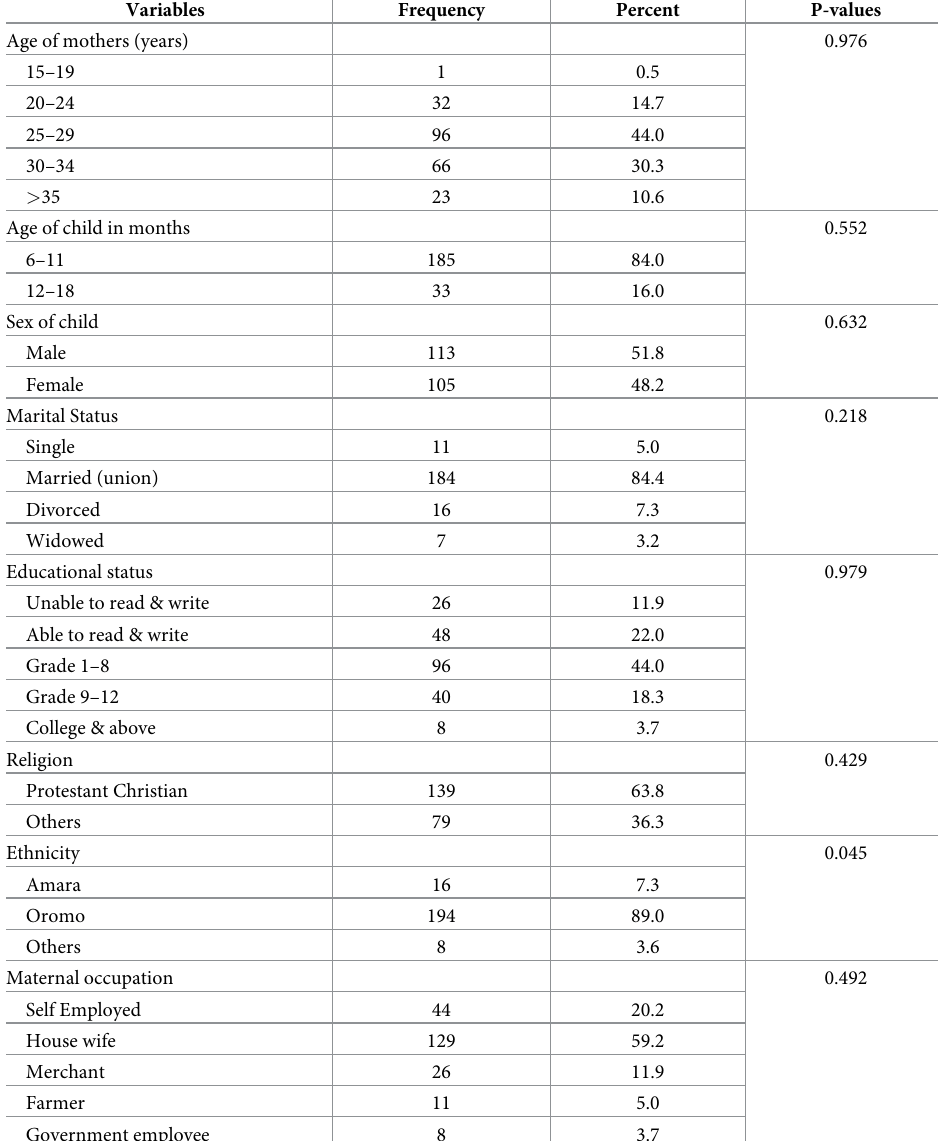
Table 1. Socio-demographic characteristics of study participants (n = 218), West, East and Kellem Wollega Dis- tricts health institution west Ethiopia, September 2017 to June 30,